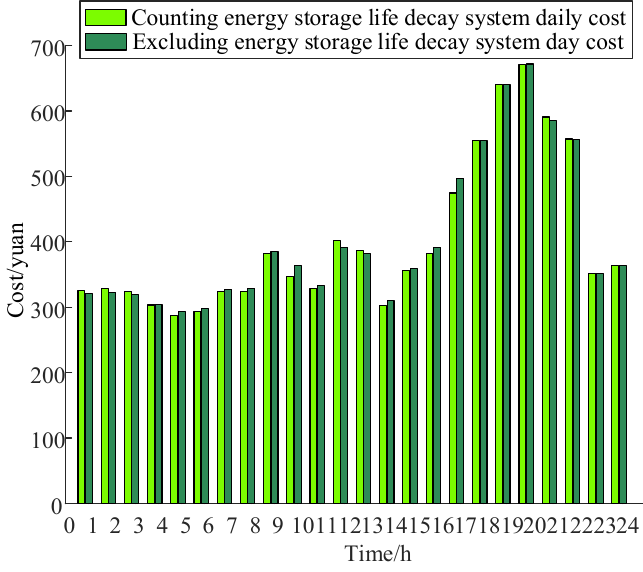
Figure 10. Total cost diagram of system operations in two